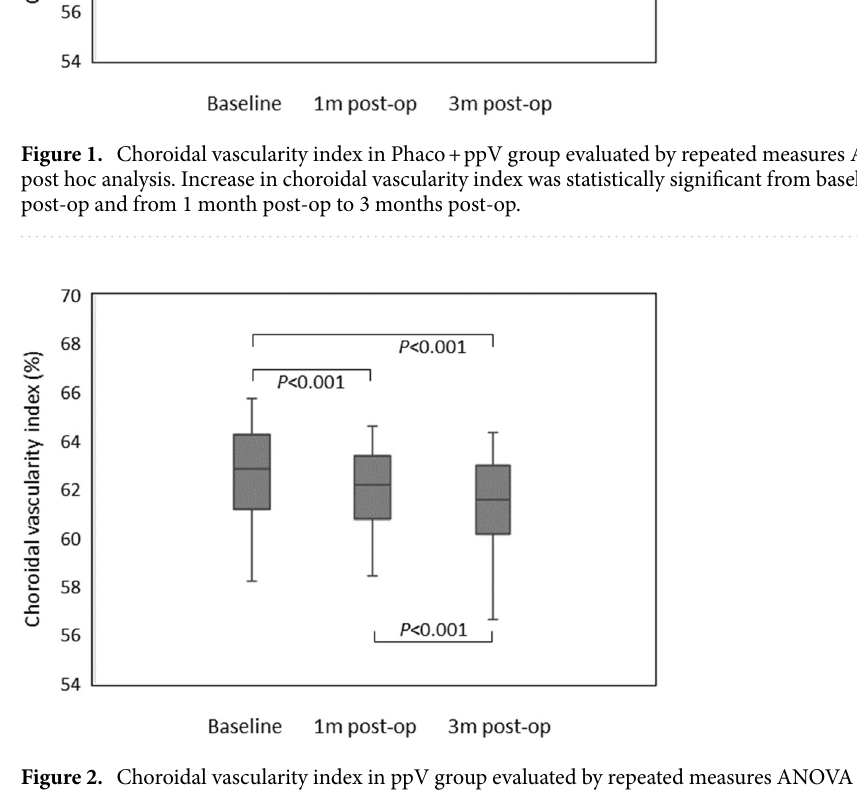
Figure 2. Choroidal vascularity index in ppV group evaluated by repeated measures ANOVA tests and post hoc analysis. Reduction in choroidal vascularity index was statistically significant between every group.